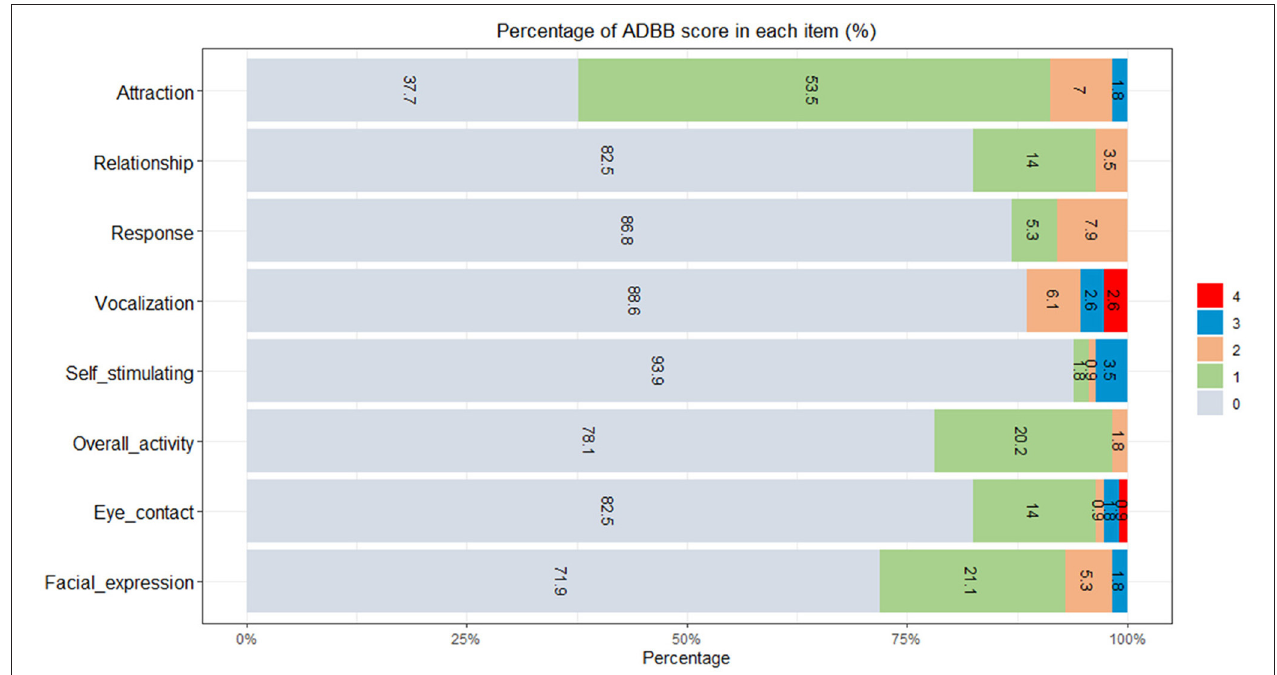
FIGURE 1 | Distribution of the alarm distress baby scale (ADBB) item score ( N = 114).